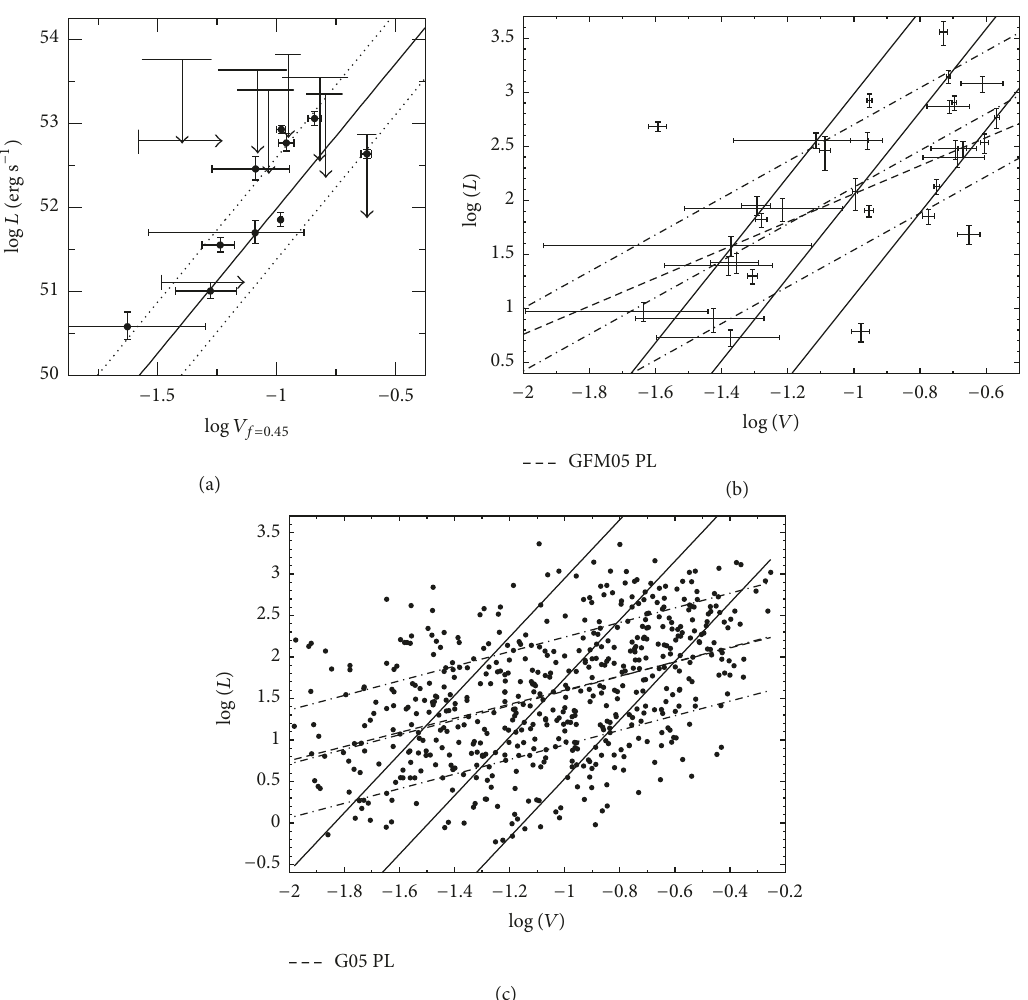
Figure 3: (a) The variabilities 𝑉 𝑓=0.45 and peak luminosities 𝐿 of the data set, excluding GRB980425. In this case, 𝑉 𝑓=0.45 indicates peak the variabilities for the 45% smoothing timescale of the light curve. The solid and dotted lines are the best-fit line and 1𝜎 deviation, respectively, in log 𝐿 -log 𝑉 𝑓=0.45 plane. (Figure after Reichart et al. [102]; see Figure 9 therein. @ AAS. Reproduced with permission.) peak (b) The log 𝐿 -log 𝑉 plane for the sample of 32 GRBs with measured redshift. The best-fit lines and 1𝜎 deviations are also displayed: solid peak lines are computed with the Reichart et al. [102] method, dashed-dotted lines with the D’Agostini [153] method, and the dashed lines are recovered by Guidorzi et al. [149]. (Figure after Guidorzi et al. [151]; see Figure 1 therein.) (c) log 𝐿 -log 𝑉 relation for the set of 551 BATSE peak GRBs. The best-fit lines and 1𝜎 regions are also shown, the solid lines are fitted with the Reichart et al. [102] method, the dashed-dotted lines with the D’Agostini [153] method, and the dashed lines are recovered by Guidorzi et al. [149]. (Figure after Guidorzi et al. [151]; see Figure 2